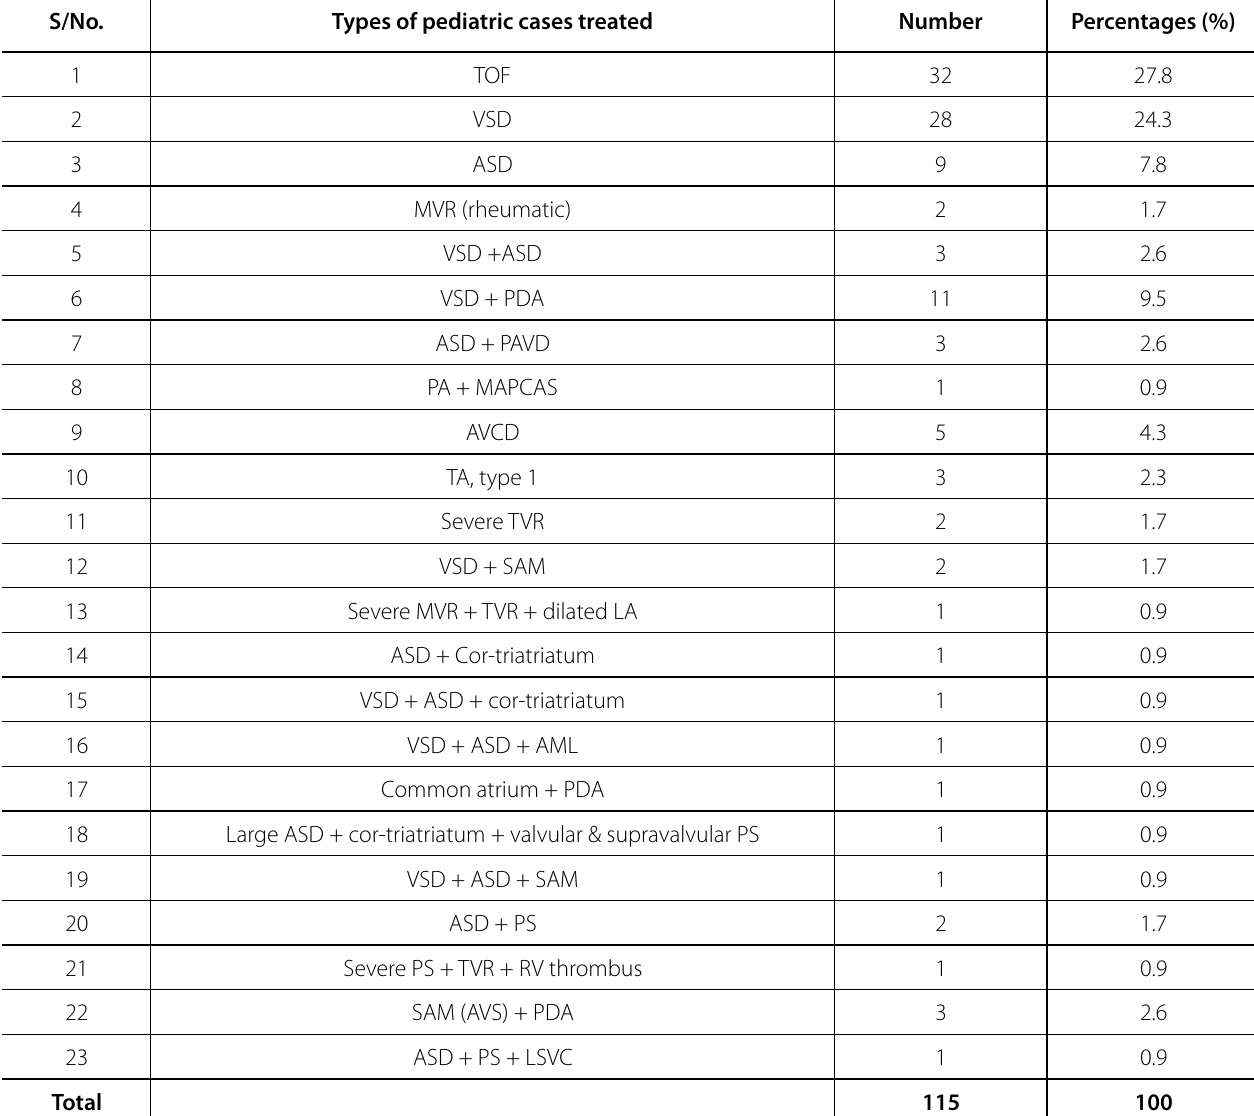
Table 4 . Types and number of pediatric cases treated.